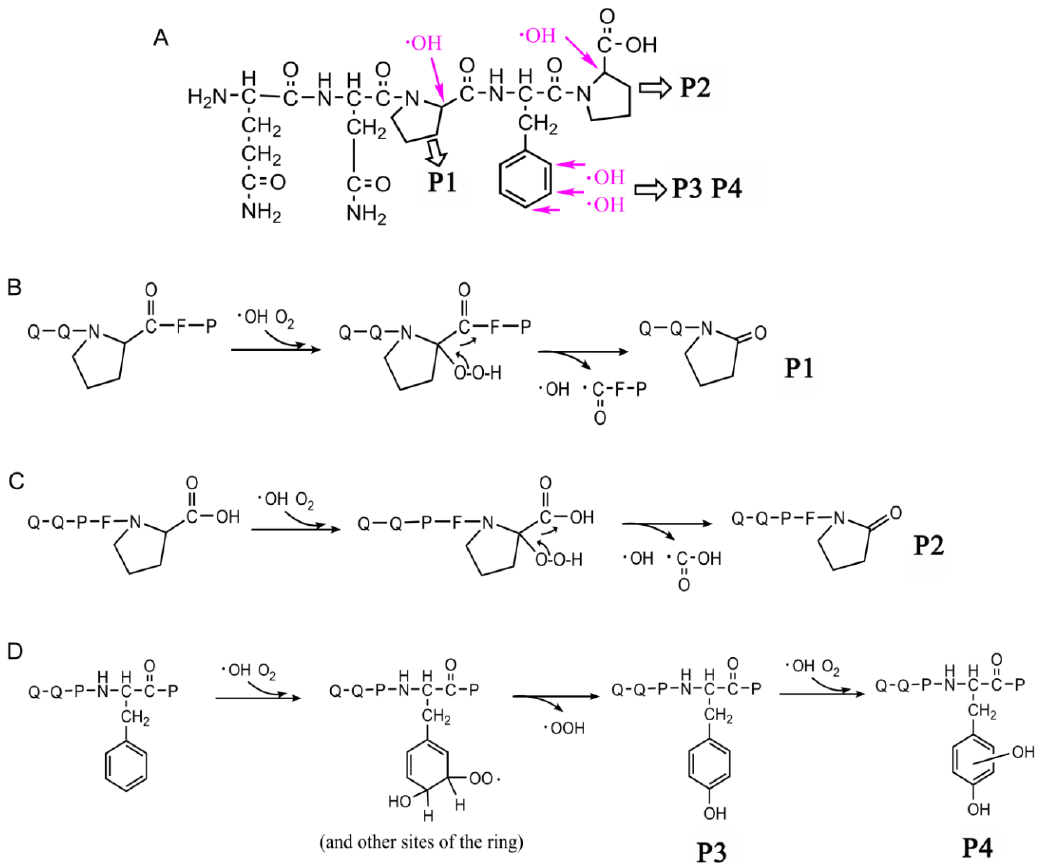
Figure 6. Structures of the celiac-toxic peptide QQPFP and its CJAP plasma-modified products referred to in this research (P1~P4), which were detected by Orbitrap HR-LC-MS/MS. ( A ) Structural changes in QQPFP during CJAP plasma treatment. The arrow shows the sites that were attacked at the intermediate region and C-terminus of the specific pentapeptide in this study. ( B ) The reaction pathway of P1 formation involved in •OH attack at the Pro residue in the intermediate region. ( C ) The